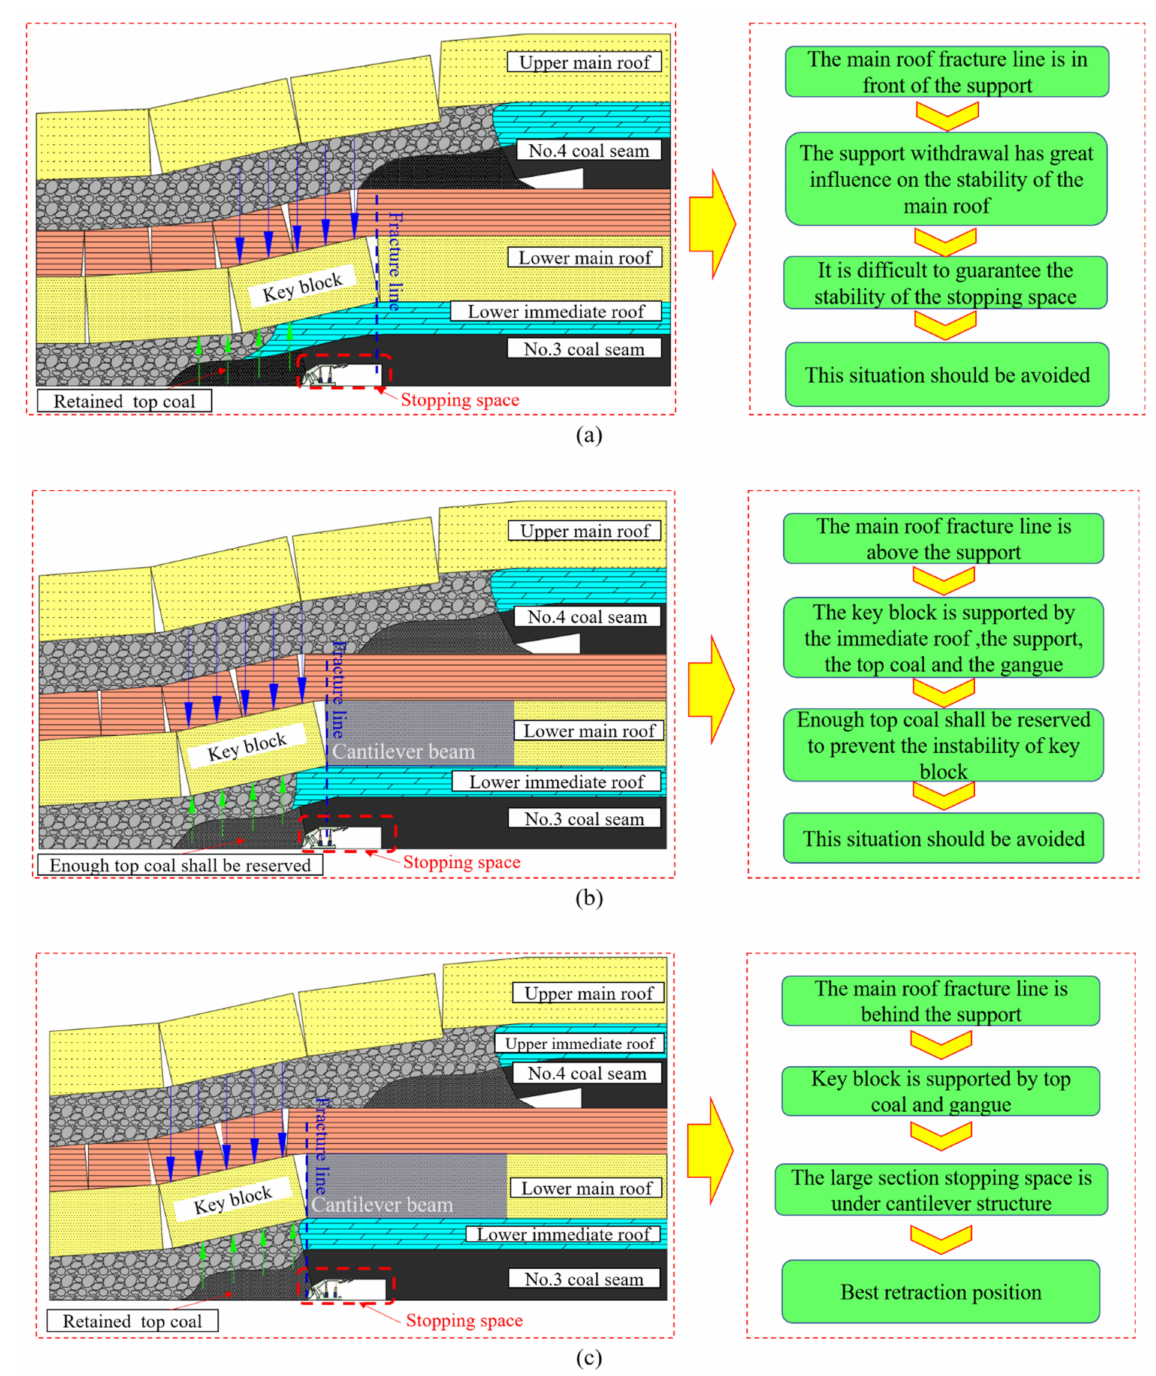
Figure 5. Schematic diagram of different stopping positions under the goaf. ( a ) The main roof fracture line is in front of the support. ( b ) The main roof fracture line is above the support. ( c ) The main roof fracture line is behind the